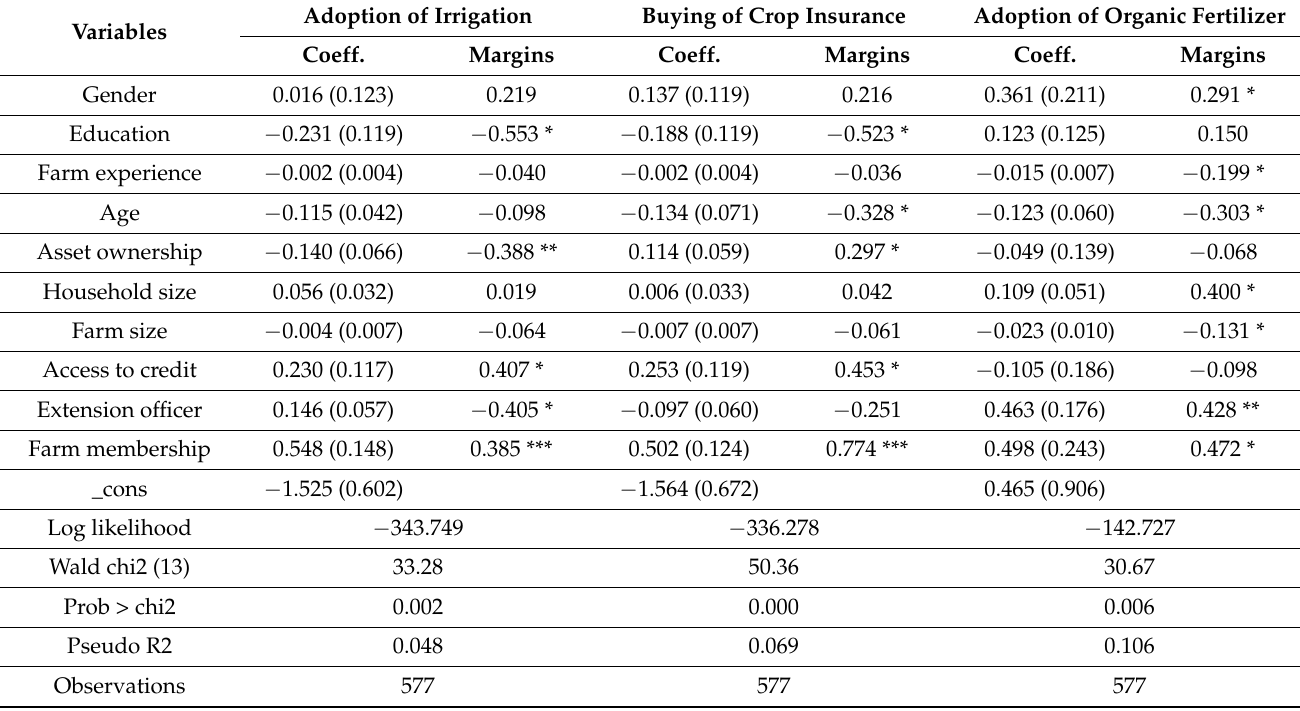
Table 5. Determinants of climate-smart agricultural